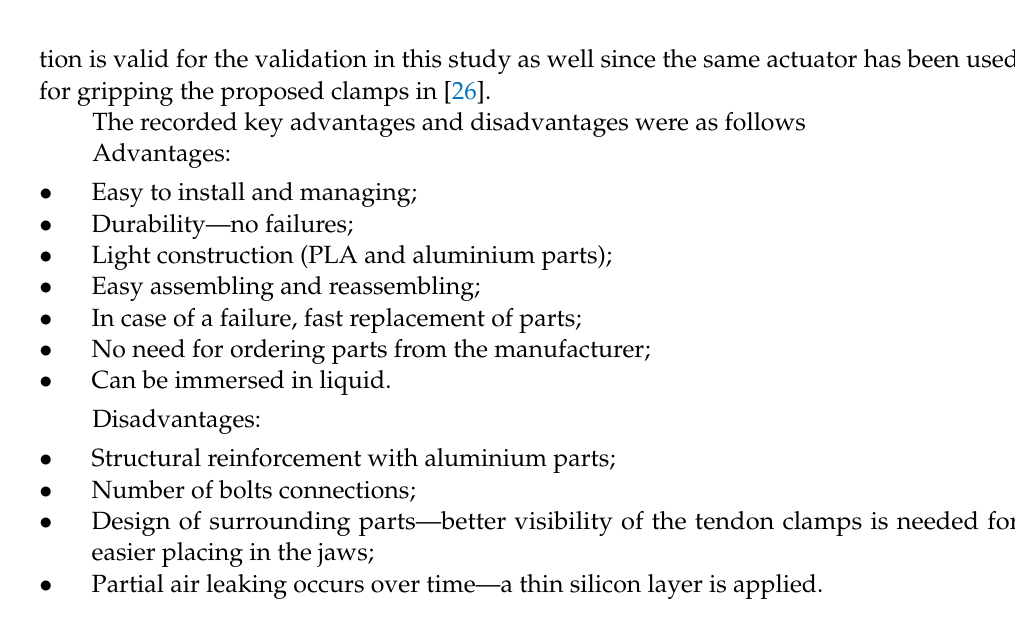
Figure 10. The main dimensions of the cylinder geometry. The assembled and mounted actuator on the machine is presented below in Figure 11.